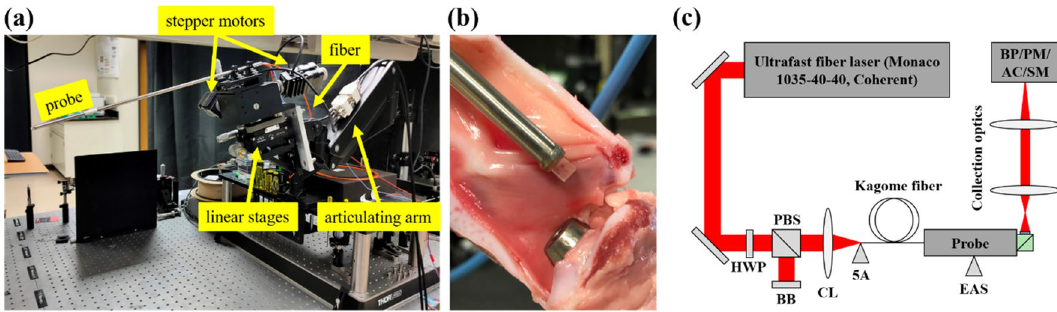
Figure 2. ( a ) Surgery system with probe integrated into external actuation system. ( b ) Probe tip placement on inferior porcine VF surface. ( c ) Experimental setup included a half-wave plate (HWP), polarizing beam splitter (PBS), beam block (BB), fiber coupling lens (CL), five-axis stage (5A), and external actuation system (EAS). Collection optics (CO) were modified based on the resolution and/or output beam size required for the beam profiler (BP), power meter (PM), autocorrelator (AC), or spectrometer